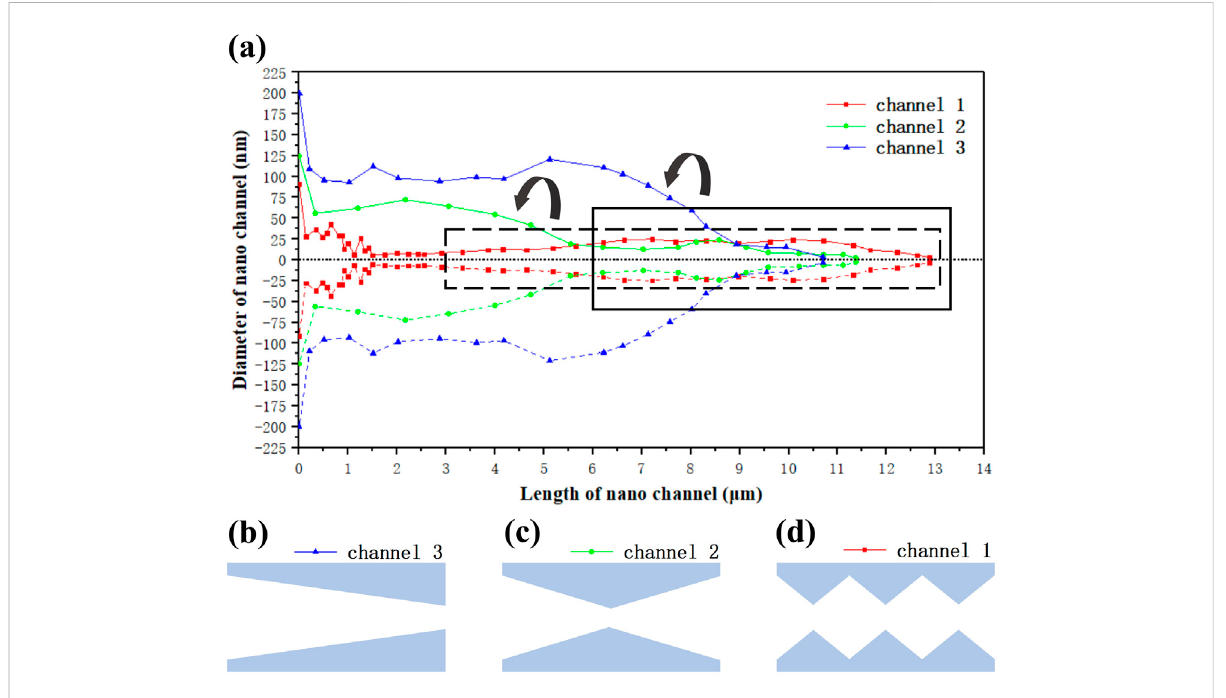
FIGURE 5 Results of the internal morphological characterization of the nanochannels (color online). (A) Channel one (red), channel two (green), and channelthree(blue)frominsidetooutside.Thenanochannelsof (B) typeoneasconicalshape, (C) typetwoashourglassshape,and (D) typethreeas multi-cavity cascade